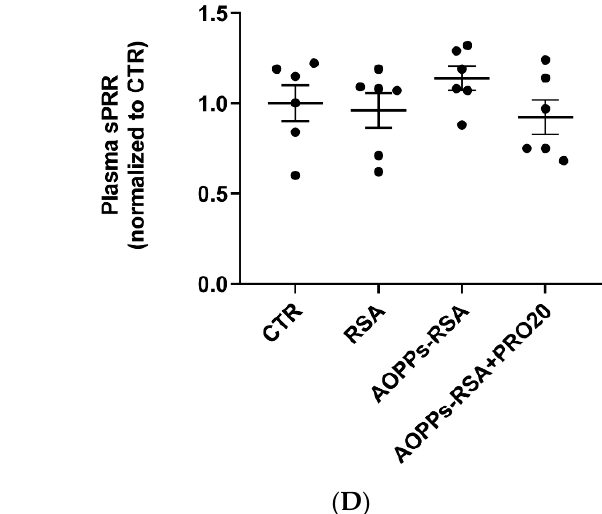
Figure 5. Expression analysis of the PRR/sPRR. Notes: ( A ) mRNA levels of PRR were measured by RT-qPCR. ( B ) Protein levels of fPRR and sPRR in renal cortex was assessed by immunoblotting. The normalized quantitative data for β -actin are shown below each blot. ( C ) Urinary sPRR excretion was analyzed with ELISA. ( D ) Plasma sPRR was analyzed with ELISA. Results are presented as mean ± SEM. n = 6 per group. * p < 0.05, compared to the CTR group. PRR: (Pro)renin receptor; fPRR: full- length PRR; sPRR: soluble PRR.